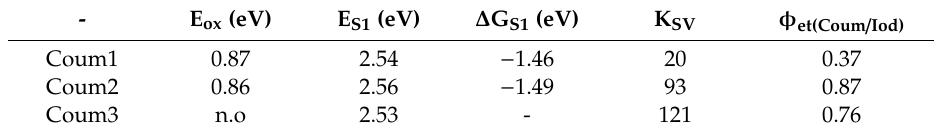
Table 3. Parameters characterizing the chemical mechanisms associated with the 1 Coum / Iod interaction in